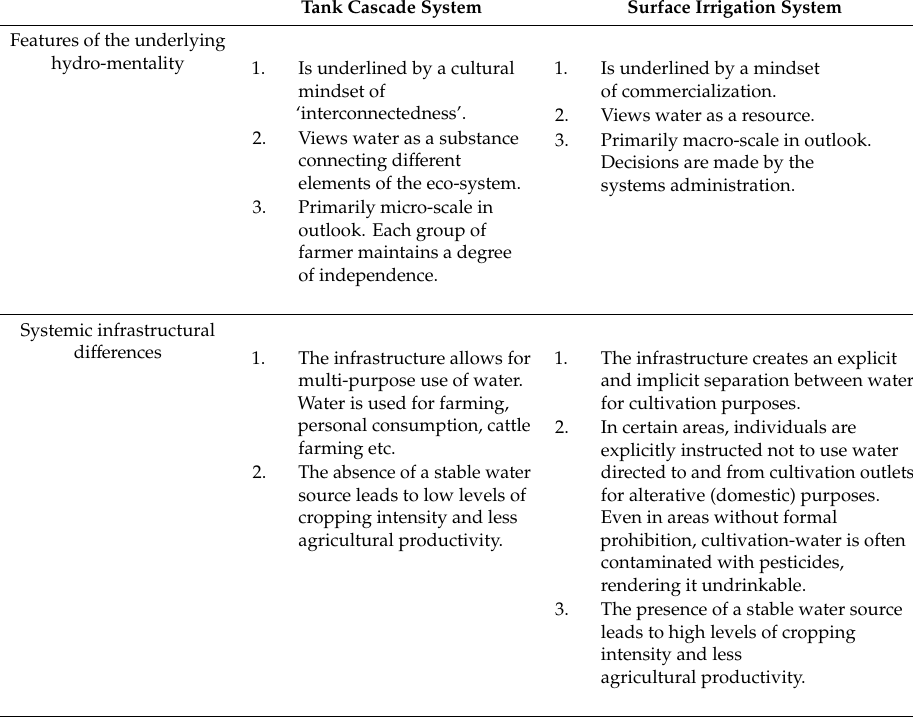
Table 1. A comparison of the hydro-mentalities and associated water infrastructure in the tank cascade system and the surface irrigation